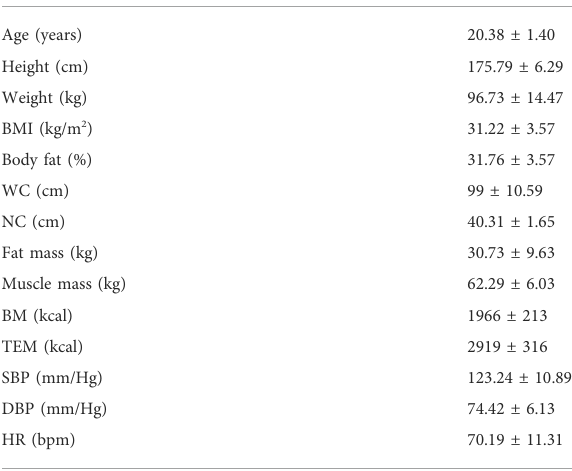
TABLE 1 Basic information of the participants ( n =